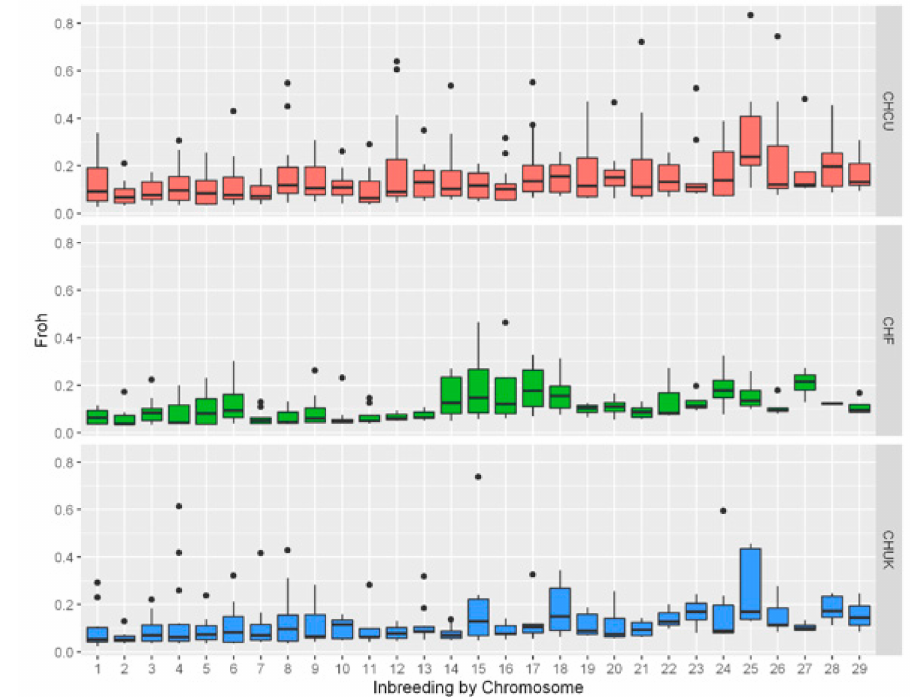
Figure 1. Distribution of genomic inbreeding estimates for each chromosome (F ROH_BTA ), calculated as the proportion of BTA (F ROH by chromosomes) in ROHs over the length of the BTA covered by the involved SNPs. The x -axis represents the chromosomes, and the y -axis represents F ROH values in boxplot; black points are maximum values. ROH, run of homozygosity; CHF, French Charolais; CHCU, Charolais de Cuba; and CHUK, British Charolais.